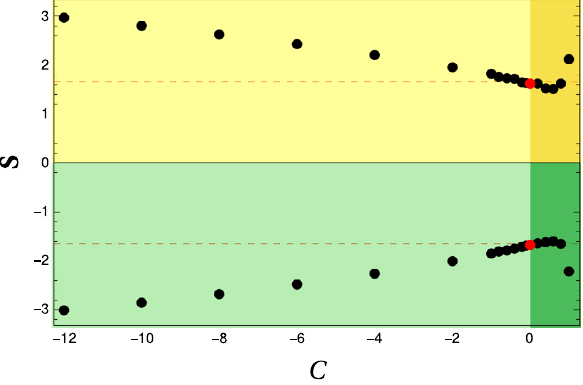
Fig. 6 Phaseplotbetweentheparameters S and C ,showstheboundon the particle’s spin S for different set of values of parameter C in the case a = 0. The permitted region is between the curves formed by the dots. Here, light and dark yellow regions represent corotating ( J z > 0) cases ofthespinningparticlearoundtheReissner–Nordstr ¨ o mlikebraneworld BH( C < 0)andtheReissner–Nordstr ¨ o mlikeBH( C > 0),respectively. The same applies for the green region representing the counter-rotating ( J z < 0) cases. The red-dot in the yellow and green regions shows the limiting value of parameter S for corotating and counter-rotating ( J z < 0)ISCOsaround SchwarzschildBH.Themassparameter M = 1